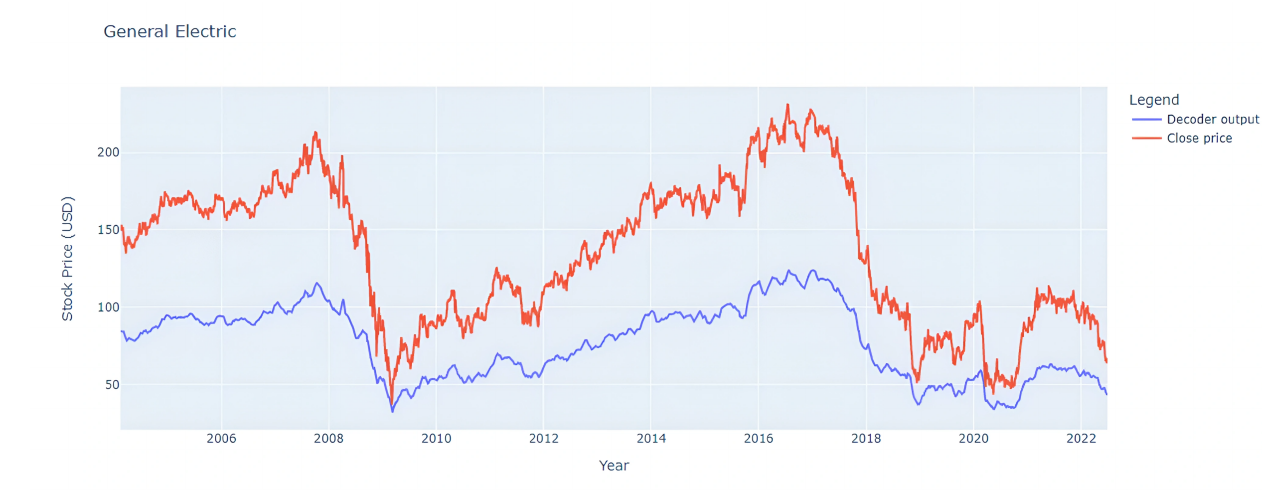
Figure 6. Output sequence of the LSTM auto-encoder.